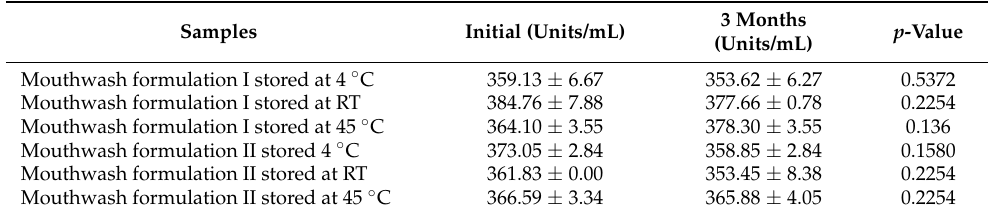
Table 4. The stability of mouthwash formulations I and II are based on enzyme activity. RT: room temperature.